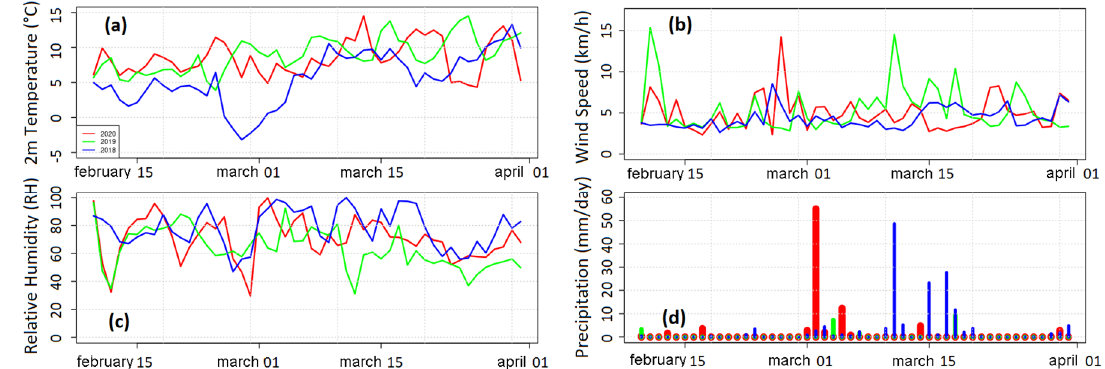
Figure 4. Trends of air temperature in Celsius degrees ( a ), wind intensity in Km / h ( b ), relative humidity in percentage ( c ), and total daily precipitation in mm ( d ), registered in Milan in the period 10 February–31 March for the years 2018 (blue lines), 2019 (green lines), and 2020 (red lines). During February and March 2020, the region was characterized by typical variability of late winter and spring weather conditions, with a dynamic sequence of anticyclonic and cyclonic